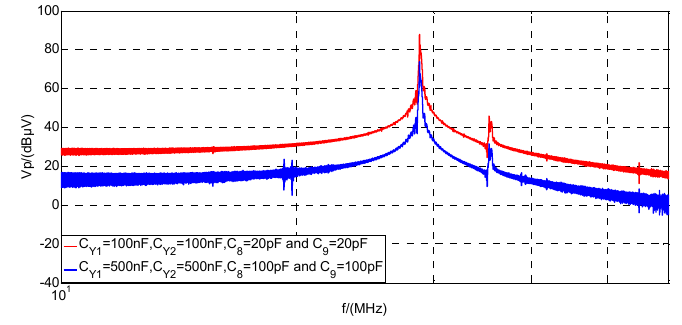
Figure 17. Positive CE voltage after C Y1 , C Y2 , C 8 and C 9 were increased.